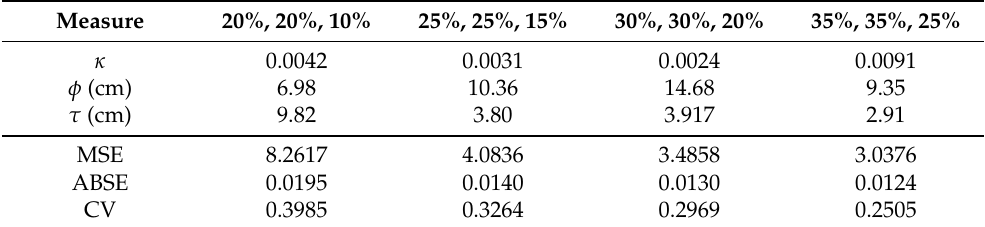
Table 5. Posterior distribution of the parameters and prediction errors in the stratified random samples